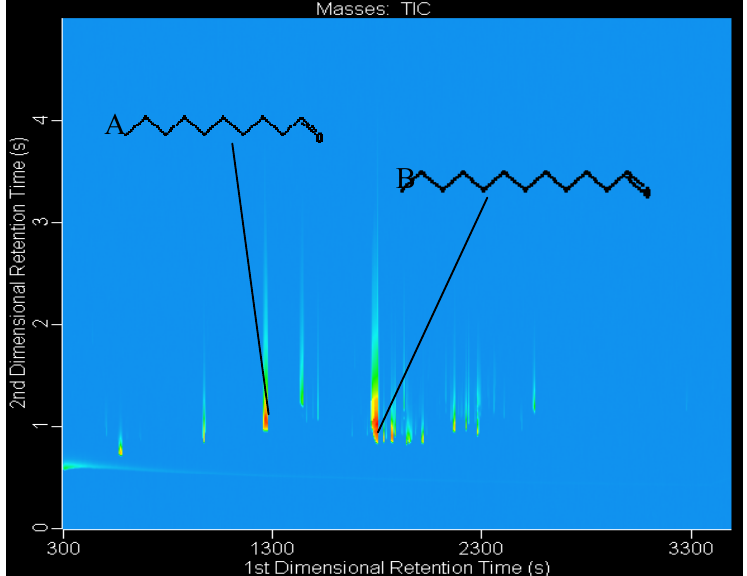
Figure 1. 2D-GC chromatogram contour plots of Polygonum minus Huds. volatile oil and structural pictures of (A) decanal and (B) dodecanal as the main constituents.